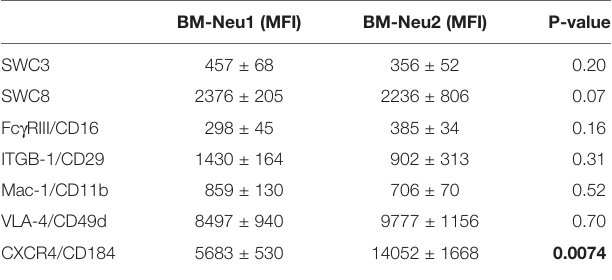
Values in bold indicate statistically signi fi cant result. Data are presented as mean ± SEM. MFI, median fl uorescence intensity in arbitrary